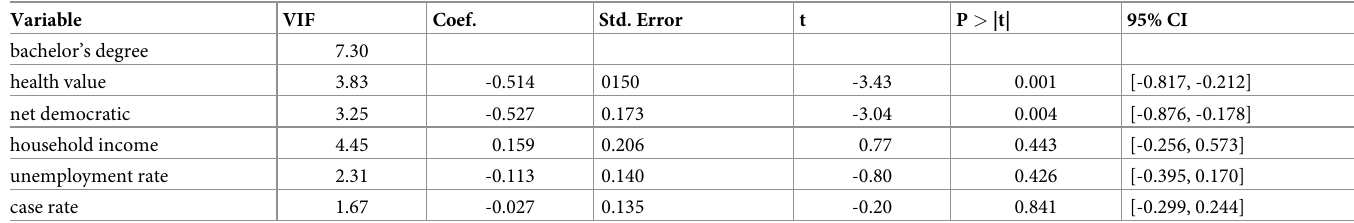
Table 3. Regression